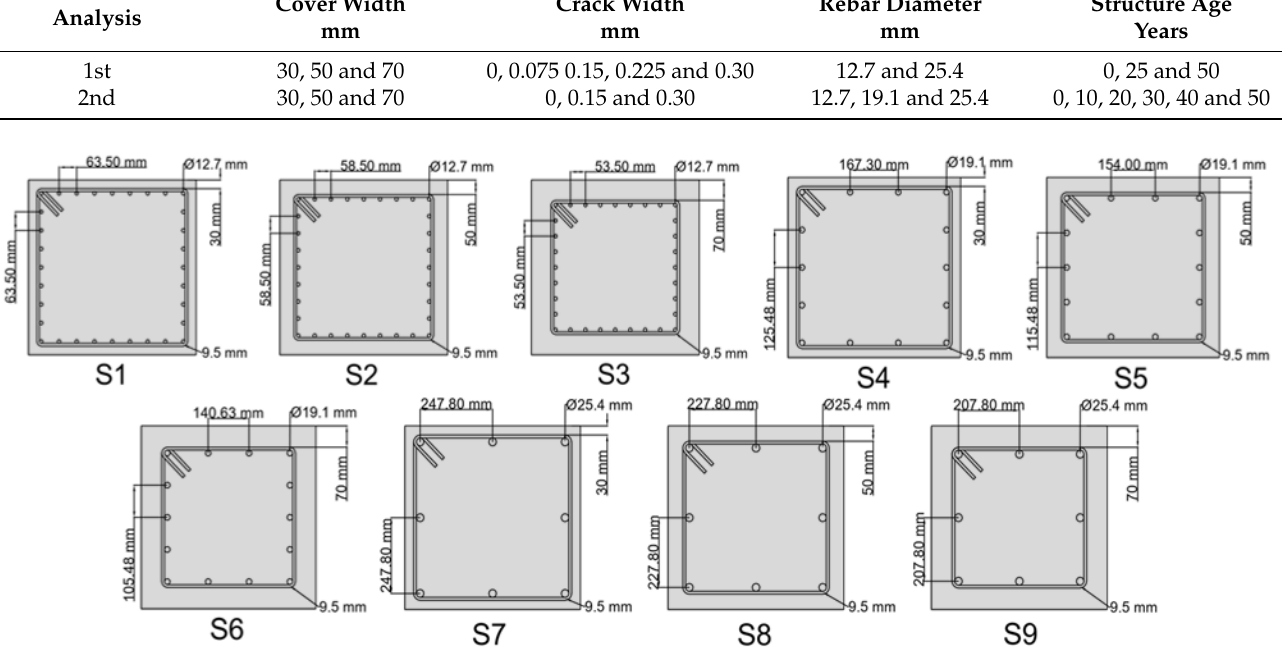
Figure 7. Structural sections evaluated in the second analysis. Table 1. Parameters and their ranges considered by the parametric analyses.